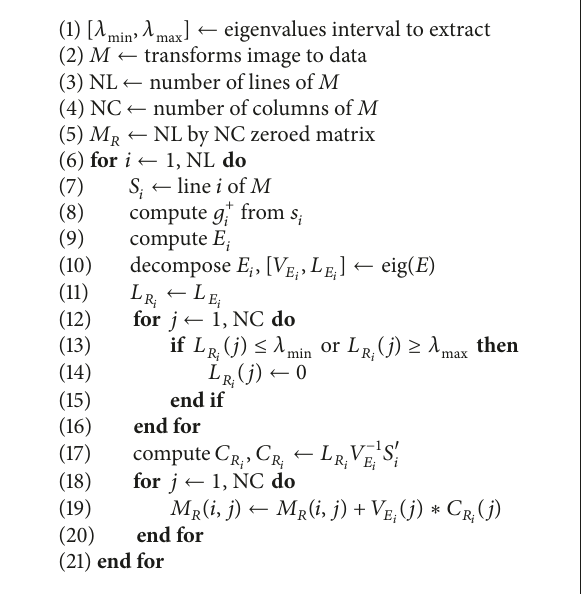
Algorithm 2: Pseudocode to extract SPMFs between two eigenval-